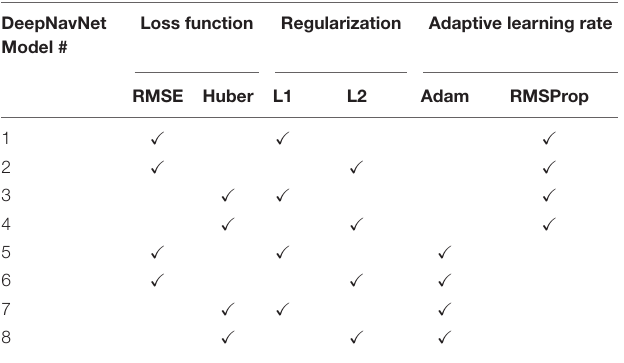
TABLE 1 | DeepNavNet training experiments. DeepNavNet Loss function Model #